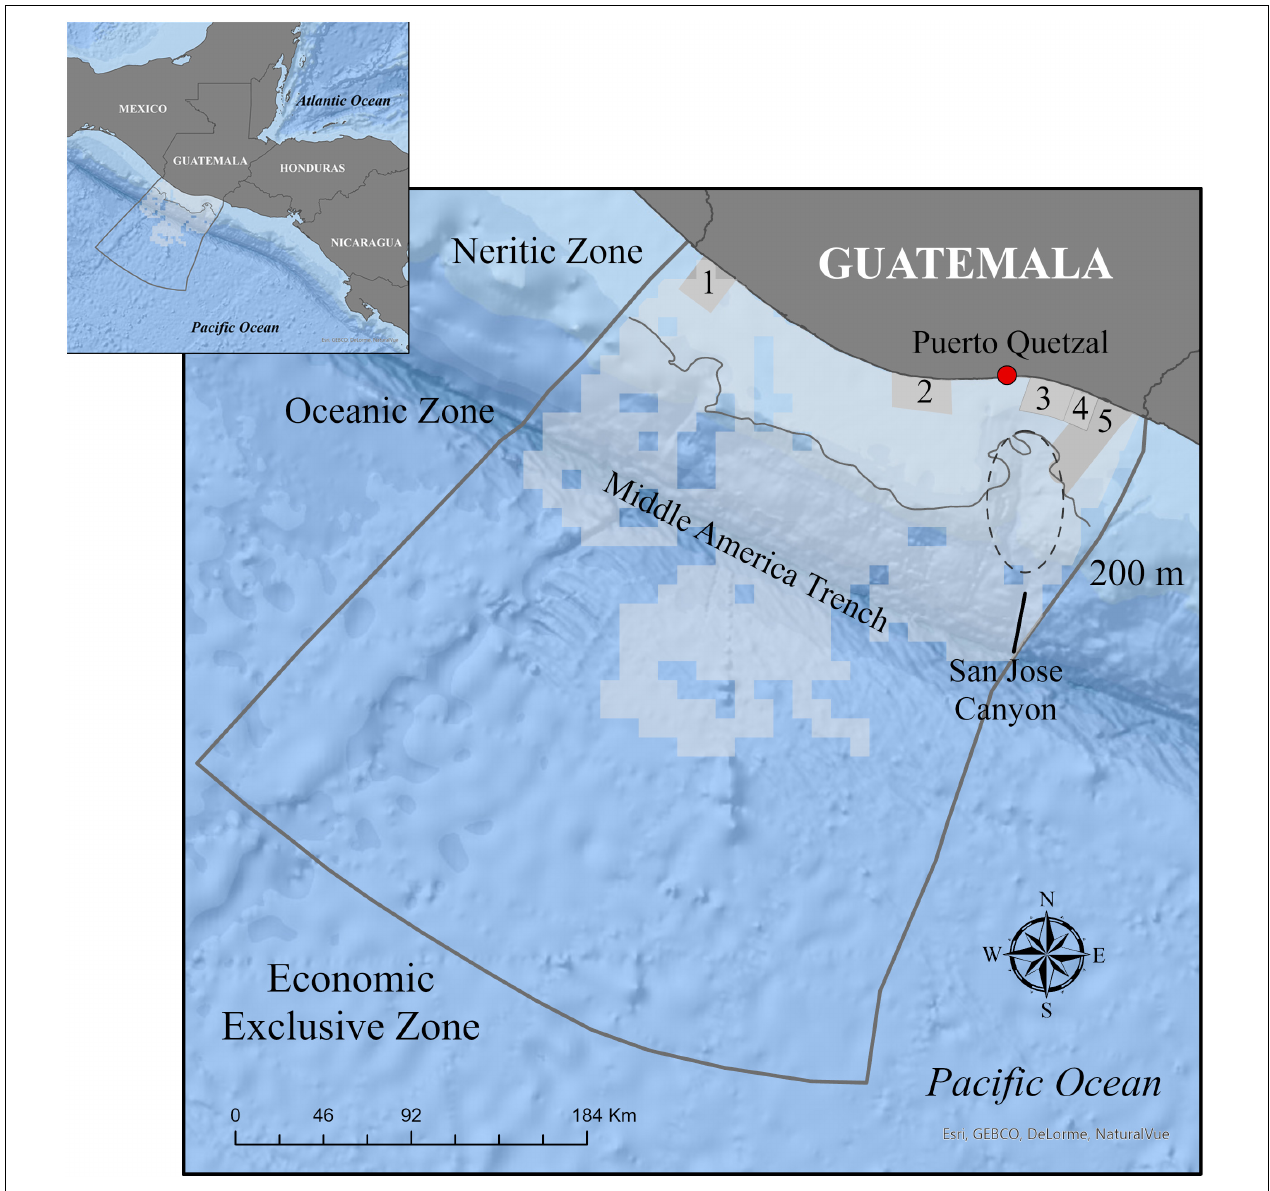
FIGURE 1 | Study area (light gray) inside the Guatemalan Pacific Economic Exclusive Zone including the neritic and oceanic zones, 200 m isobath, and coastal marine protected areas (medium gray color). Clear sections inside the study area represent sections that were not surveyed. The coastal protected areas from west to east are: (1) Manchon-Guamuchal, (2) Sipacate-Naranjo, (3) Monterrico, (4) Hawaii, and (5) Las Lisas.